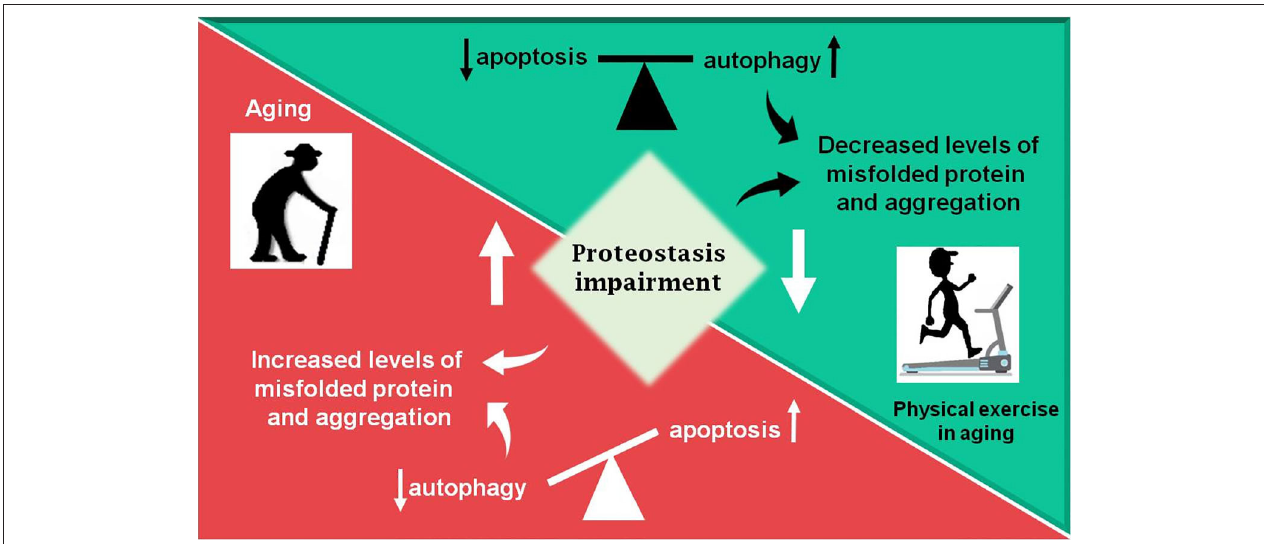
FIGURE 2 | Summary of the review. During aging (red box) an increase in proteostasis impairment is observed in the Central Nervous System, which may lead to increased levels of misfolded proteins, in part due to decreased autophagic process. The balance between apoptosis and autophagy is lost and an increase in programmed cell death is observed. Otherwise, physical exercise in aging (green box) can partially revert the disbalance observed in aging, decreasing proteostasis impairment and improving autophagic process, as well as decreasing levels of misfolded proteins and toxic protein aggregates, which lead to less apoptosis